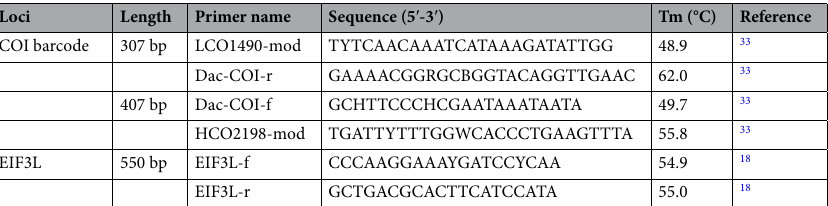
Table 3. Loci, primers and annealing temperatures used to sequence LAMP target regions and confirm sample identifications. LCO1490-mod and HCO2198-mod were paired in PCR to amplify the entire 5’-COI DNA barcode region or paired with internal Dac-COI primers to amplify shorter fragments for collection samples.